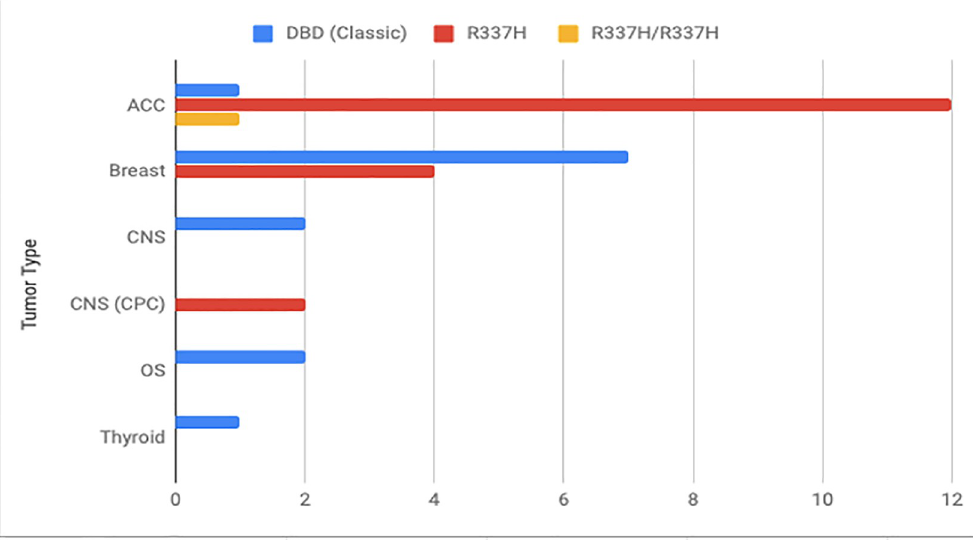
Fig 3. Graphic showing the differences between the tumor spectrum observed in carriers of the DBD variants, R337H variant and R337H homozygous proband. ACC, adrenocortical carcinoma; CNS, central nervous system; CPC, choroid plexus carcinoma; DBD, DNA binding domain; OS,